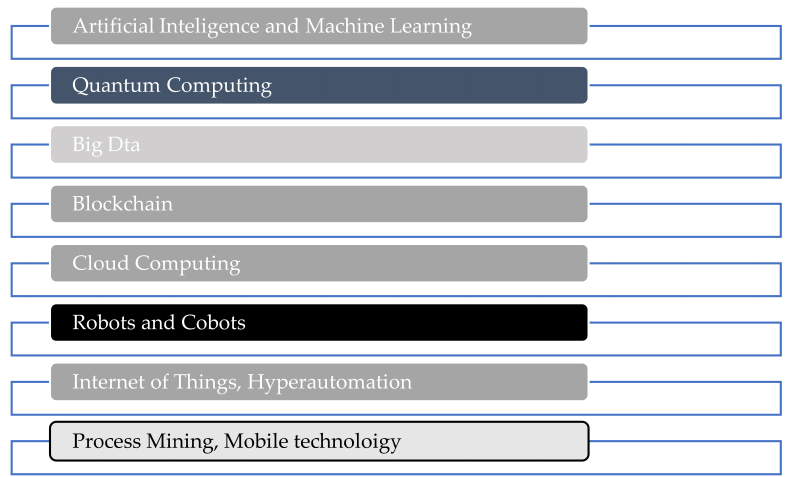
Figure 1. Technologies Driving the Fourth Industrial Revolution. Source: Author’s